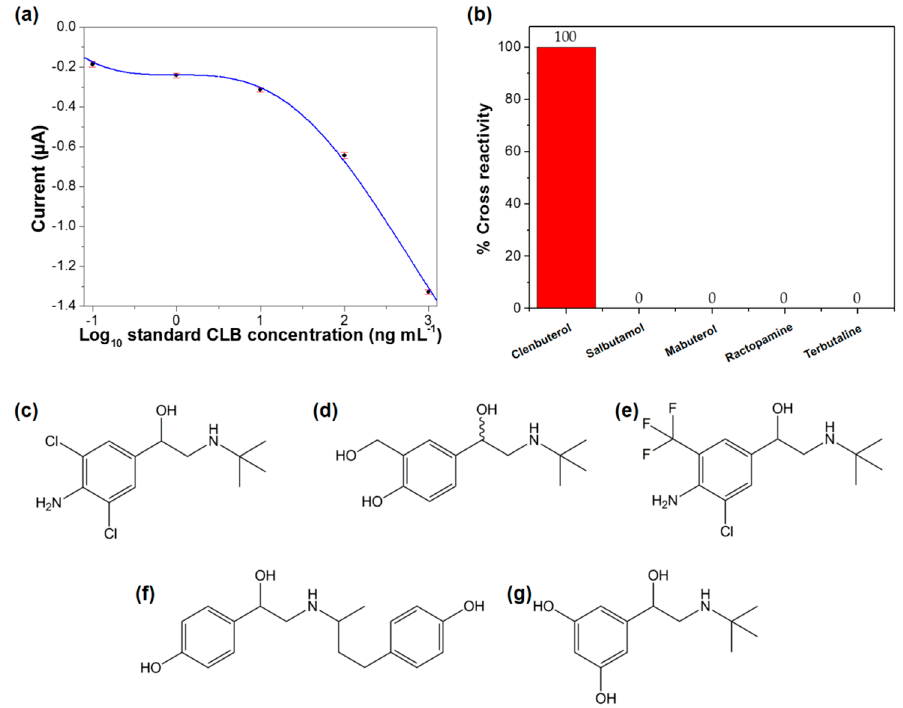
Figure 5. ( a ) The measured currents are fitted to a sigmoidal curve for estimation of limit of detection (LOD) (solid line); ( b ) Immunosensor selectivity against other antibiotics from β -agonist family. Structures of some representative of β –agonist families; ( c ) clenbuterol; ( d ) salbutamol; ( e ) mabuterol; ( f ) ractopamine; and, ( g ) terbutaline.